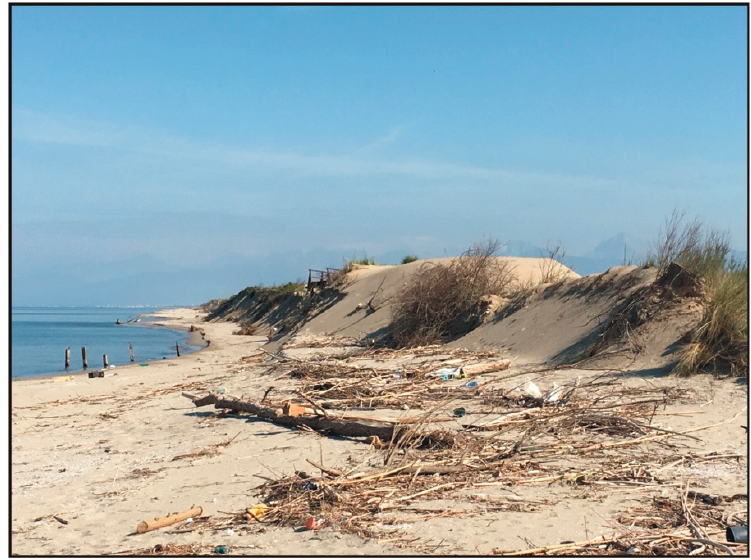
Figure 11. Eroding dunes at the Migliarino-San Rossore-Massaciuccoli Regional Park.